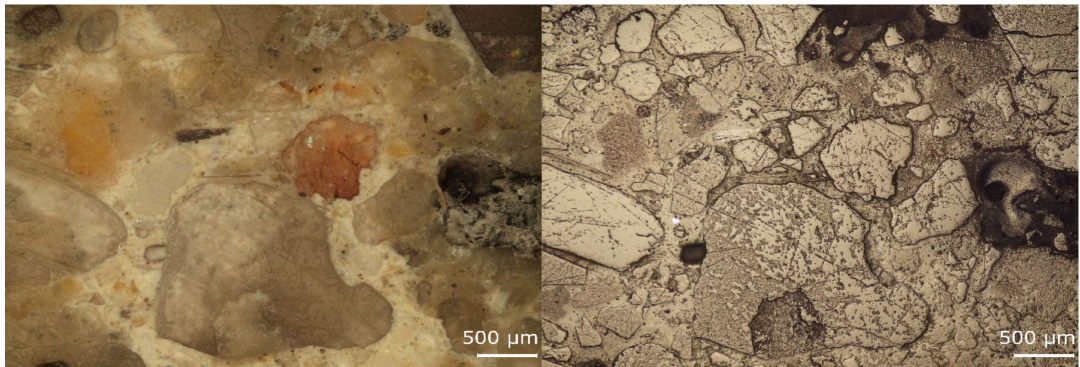
Figure 10. Microscopic images of the RC concrete sample observed under unpolarized ( left ) and polarized ( right ) light.